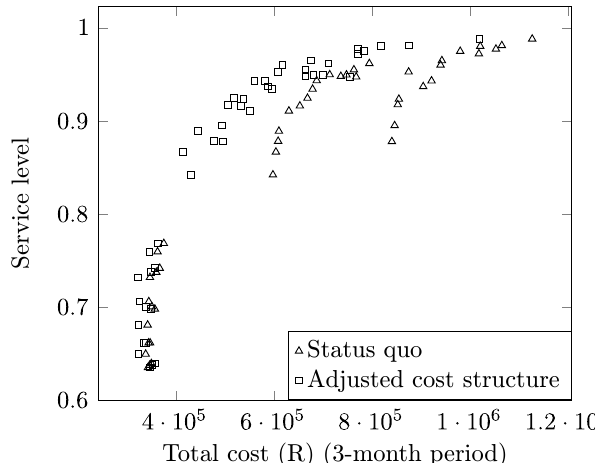
The overall difference between the status quo and the adjusted cost structures is shown here. The status quo cost structure shows clusters of solutions resulting from the distinct increase in cost when an additional vehicle is added. The results of the adjusted cost structure are more evenly distributed due to the greater emphasis on distance